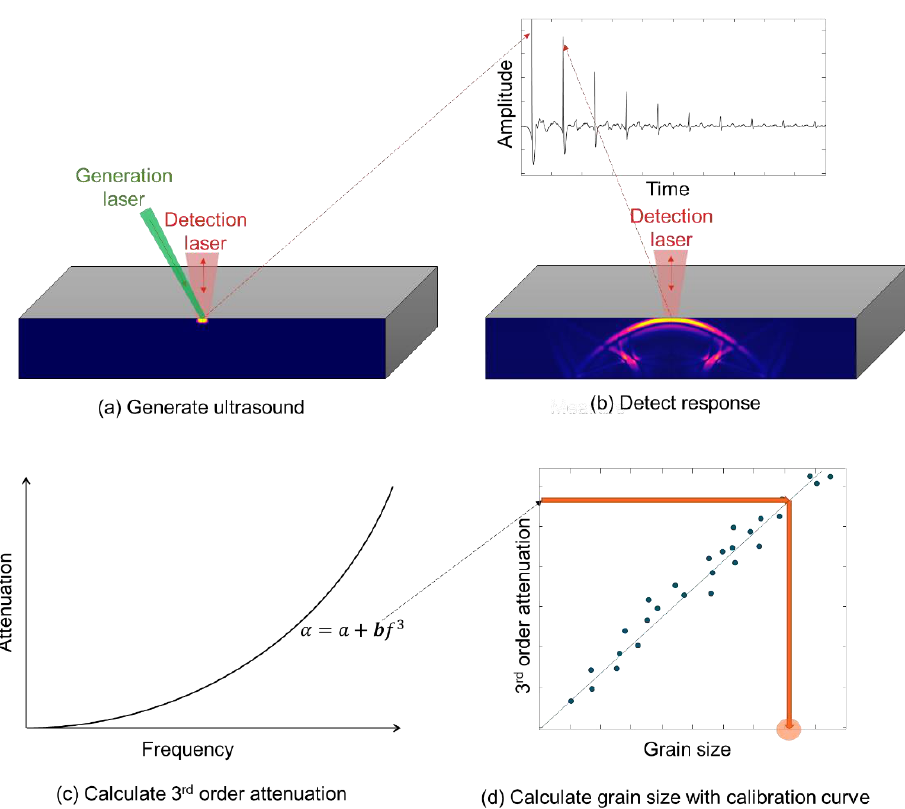
Figure 1. Schematic of the principle for laser ultrasonic grain-size measurement. ( a ) The ultrasound is generated in the sample by a generation laser hitting the surface with a short optical pulse. ( b ) The ultrasonic response of the sample is acquired with the detection laser collecting several backwall echoes. ( c ) The frequency-dependent attenuation is calculated for the backwall echoes. ( d ) The third-order frequency-dependent attenuation b is transferred by a calibration curve plotting known attenuation vs. grain sizes.